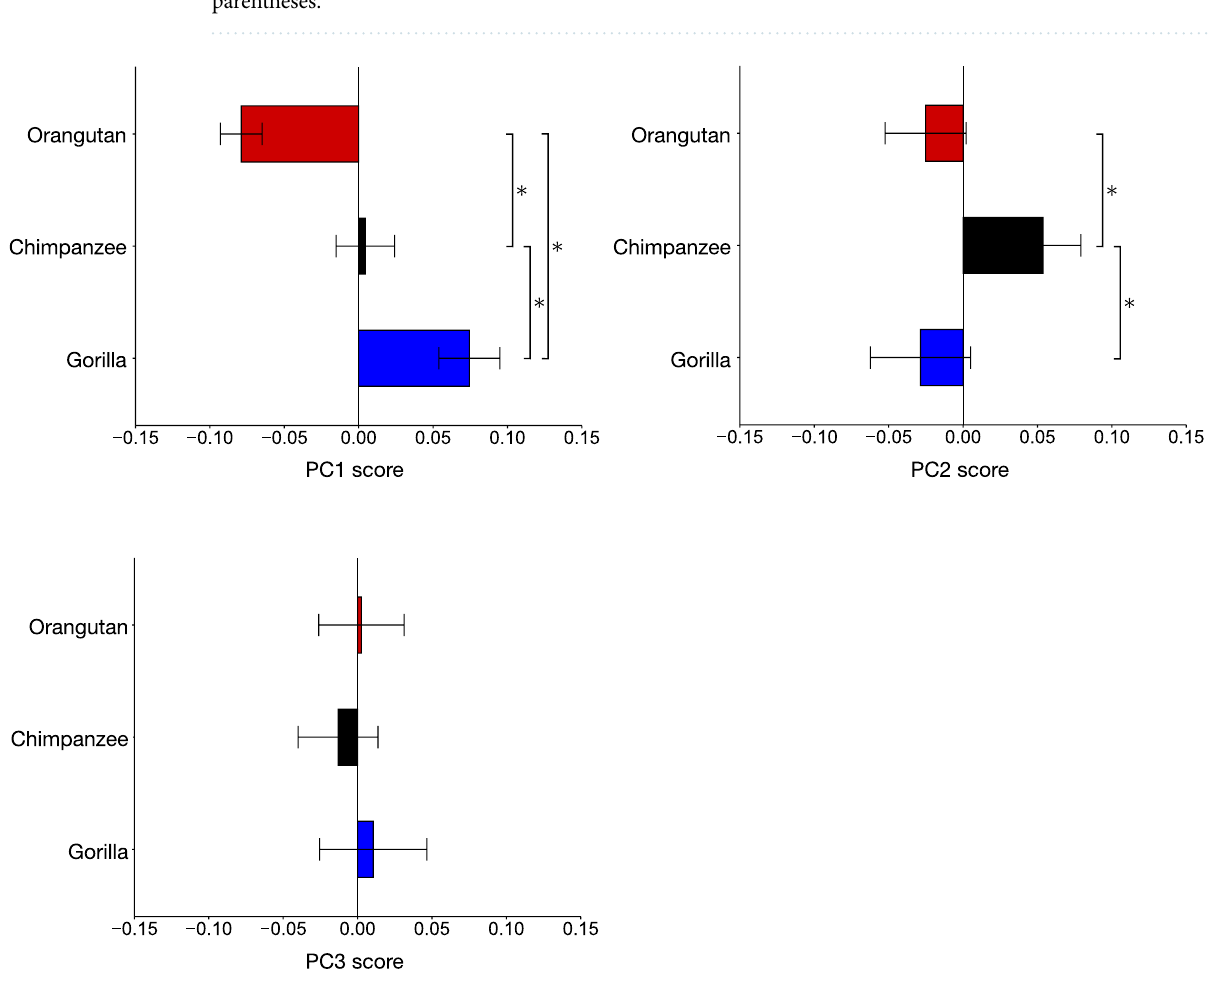
Figure 5. The results of the ape-only analysis represented as scatter plots of the principal component (PC) 1 versus PC2 ( a ) and PC3 versus PC4 ( b ). The percentage of variance explained by each PC score is shown in parentheses.